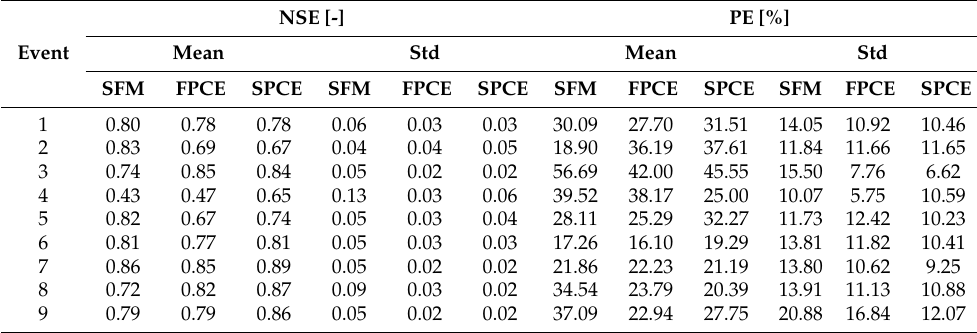
Table 3. Mean and standard deviation (Std) for 1000 values of NSE and PE for SFM, FPCE, and SPCE for nine